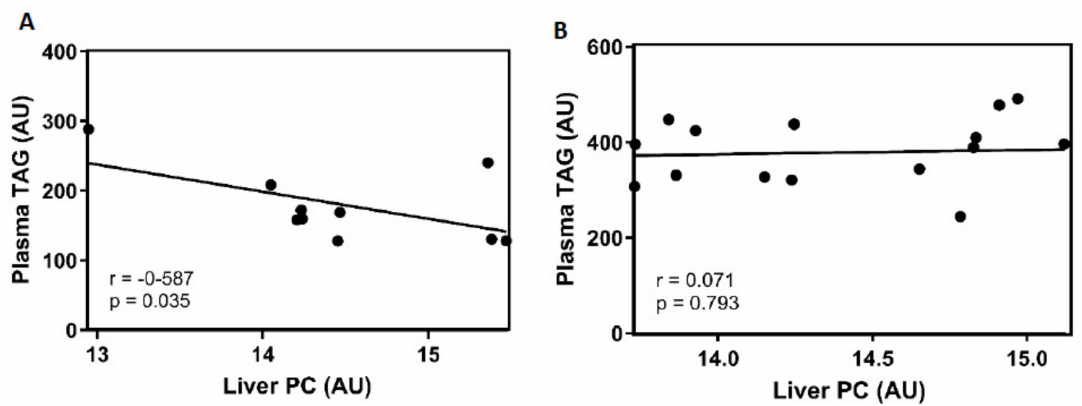
Figure 3. Plot of the significant associations between the live phosphatidylcholine and plasma triglycerides in female ( A ) and male ( B ). Each plot presents each Pearson r correlation value and the corresponding p -value. p -value < 0.05 were considered statistically